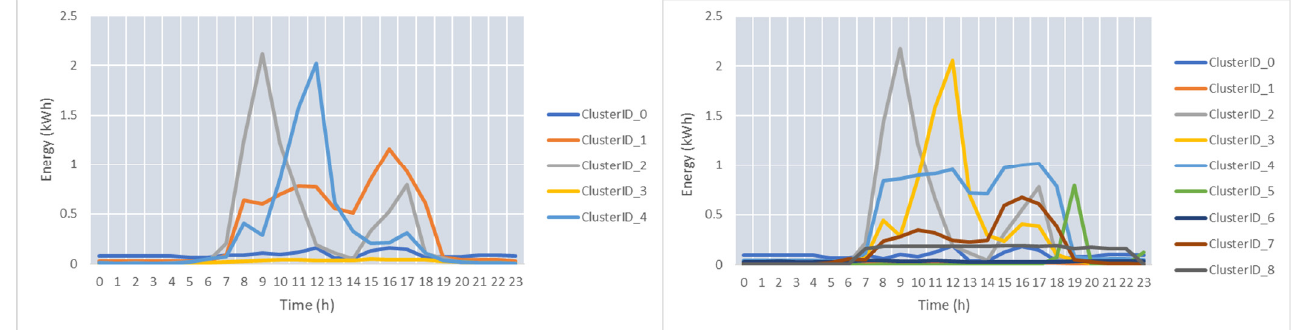
Figure 7. Energy peak ( left ) and valley ( right ) profiles clusters.